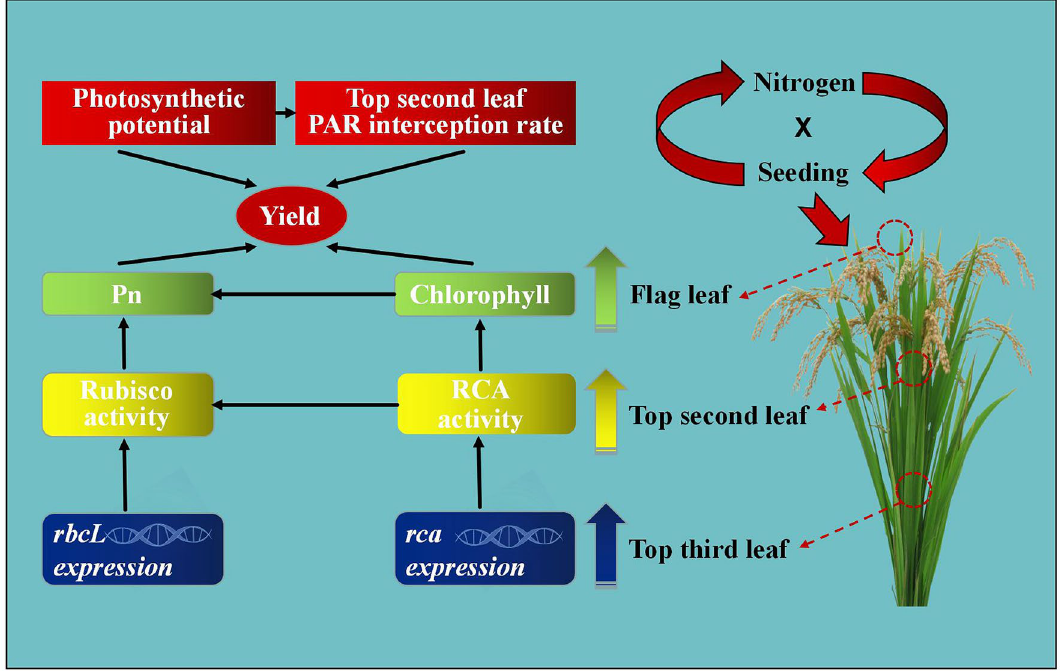
Figure 6. Mechanism underlying the formation of dominant rice populations under dry cultivation. The figures were prepared and combined using Origin 2018 (www. origi nlab.